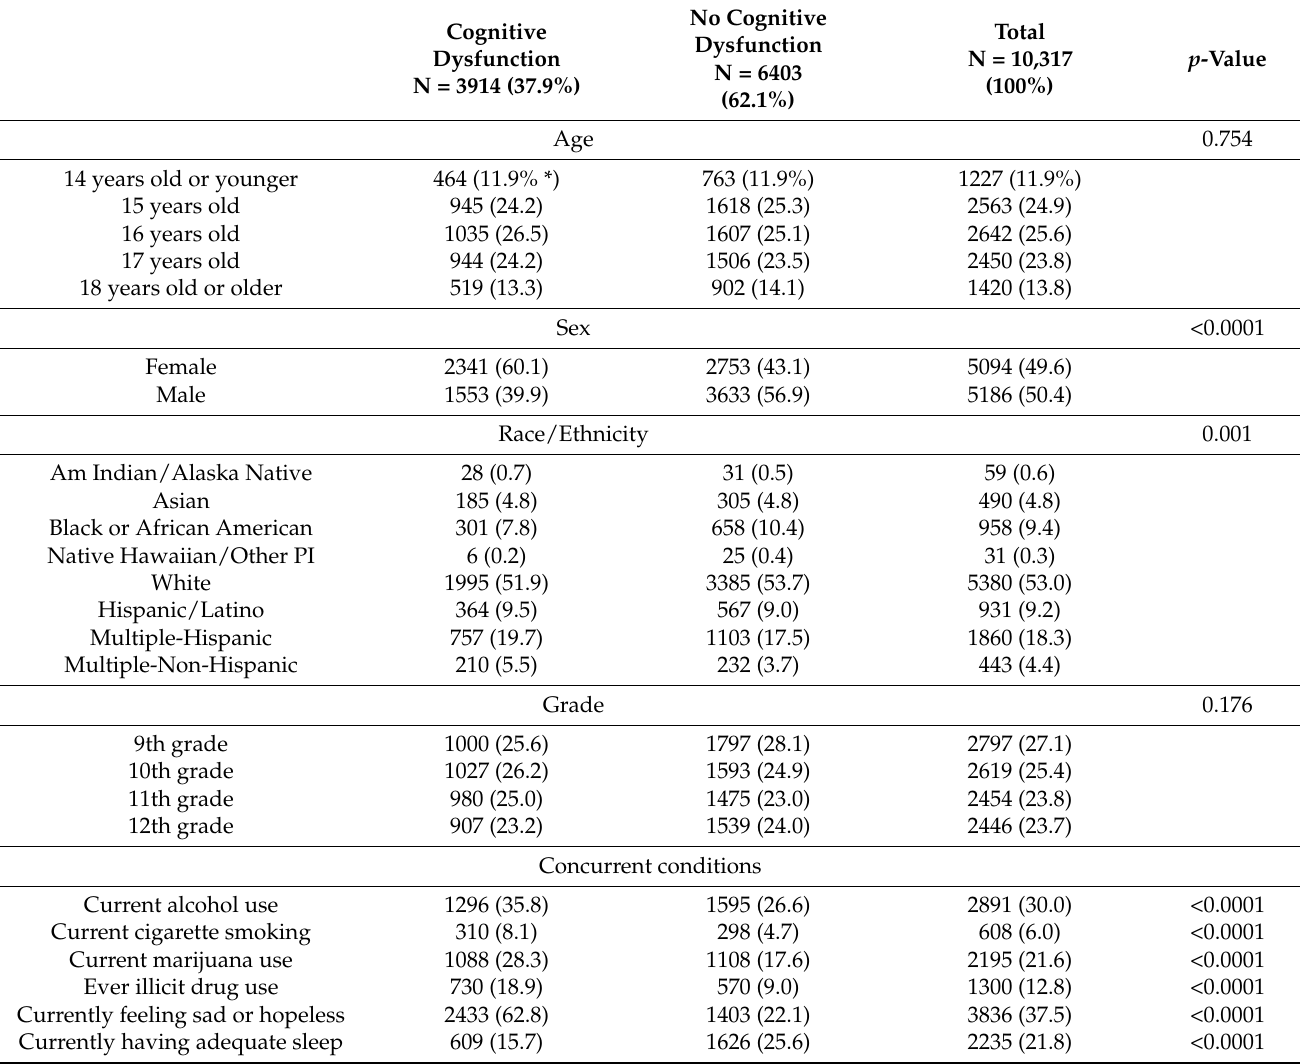
Table 1. Epidemiological characteristics and weighted prevalence of cognitive dysfunction